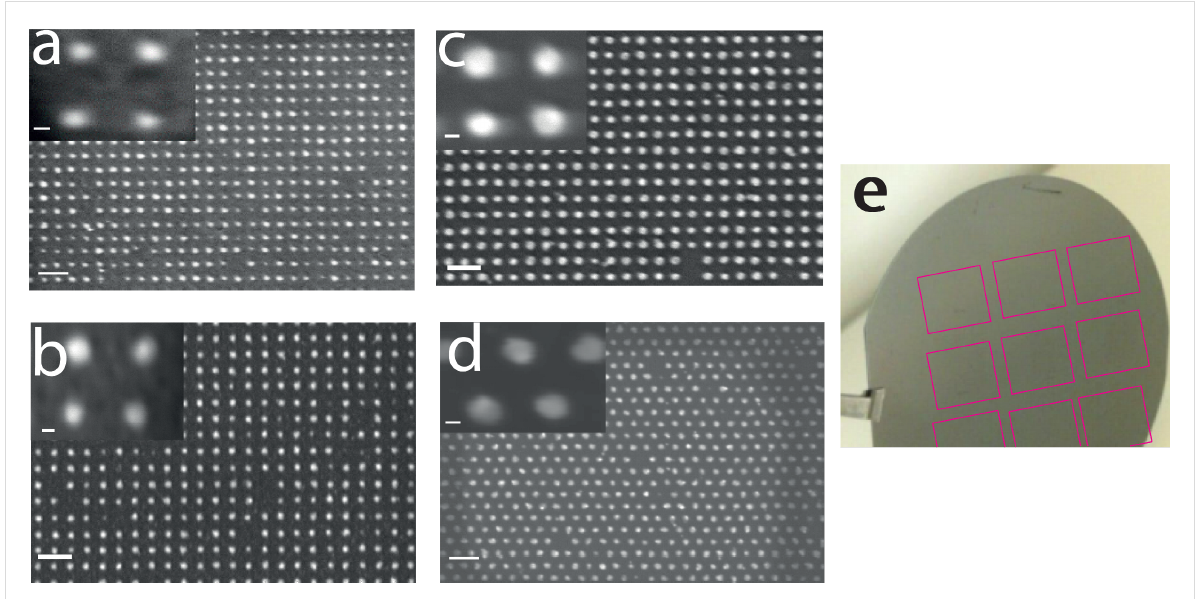
Figure 2: Scanning electron microscope (SEM) images of the gold nanodot arrays fabricated by (a) the “conventional” method with an exposure dose of 16000 µC/cm 2 (4 fC/dot), (b) the “advanced conventional” method with an exposure dose of 16000 µC/cm 2 (4 fC/dot) (c) the DOTF method with an exposure dose of 160 µC/cm 2 (4 fC/dot) (d) the “sequence” method with an exposure dose of 12000 µC/cm 2 (3.5 fC/dot). The beam current is set to 10 nA for the three techniques. The scale bar is 100 nm for the 4 SEM images and 10 nm for zoomed SEM images shown in inset. (e) Picture of a 3 inch wafer where 9 sequences of 1 cm 2 have been written using DOTF and “sequence” methods. Given the small contrast provided by the 8 nm thick gold nanoparticles, these arrays are indicated by pink squares.